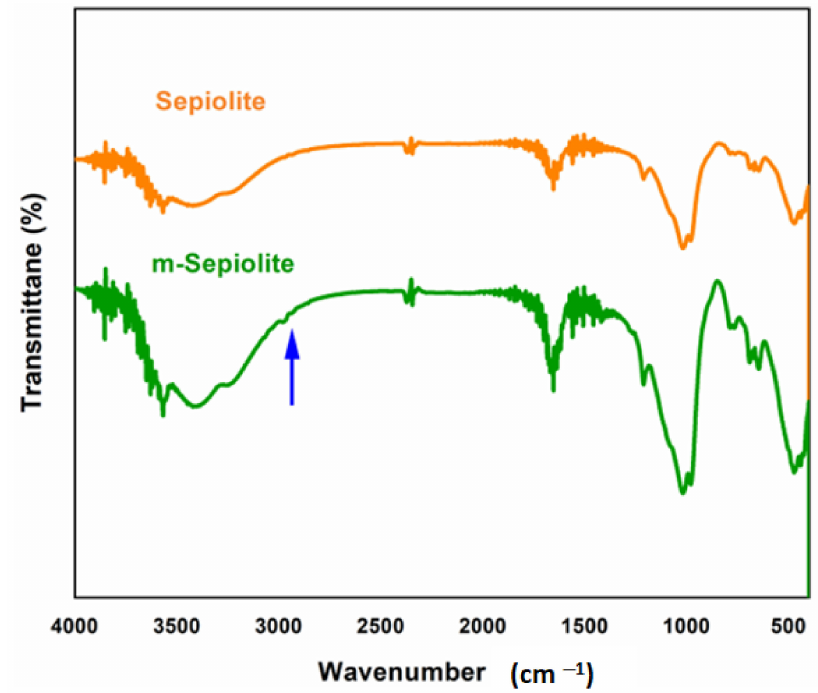
Figure 2. FTIR spectra of pristine sepiolite and modified sepiolite (m-sepiolite)